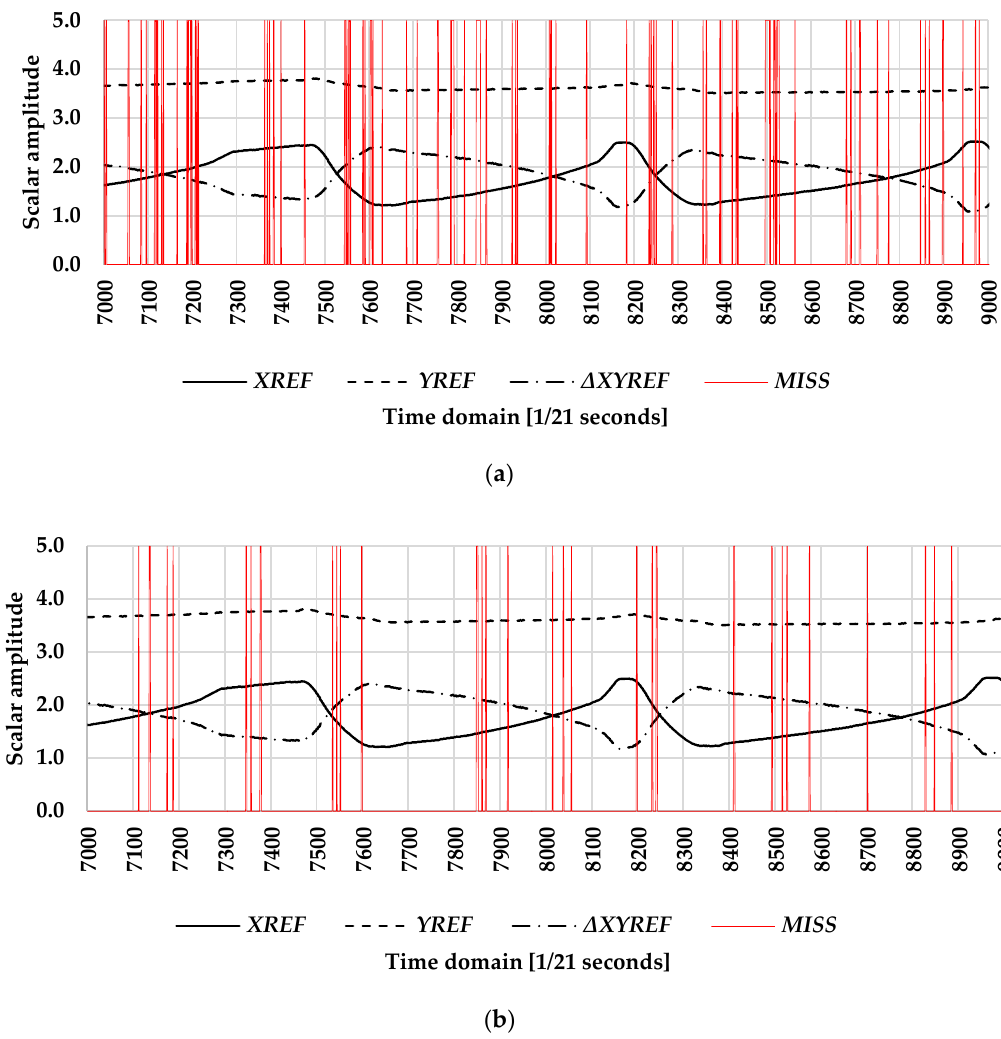
Figure 5. A partition of the original data plotted against misclassifications in the time domain: ( a ) for the FULL resolution and ( b ) for the ESSEN resolution. Legend: X REF , Y REF , and ΔXY REF have the meaning given in Table 1, MISS —misclassifications (0—absent, 5—present).